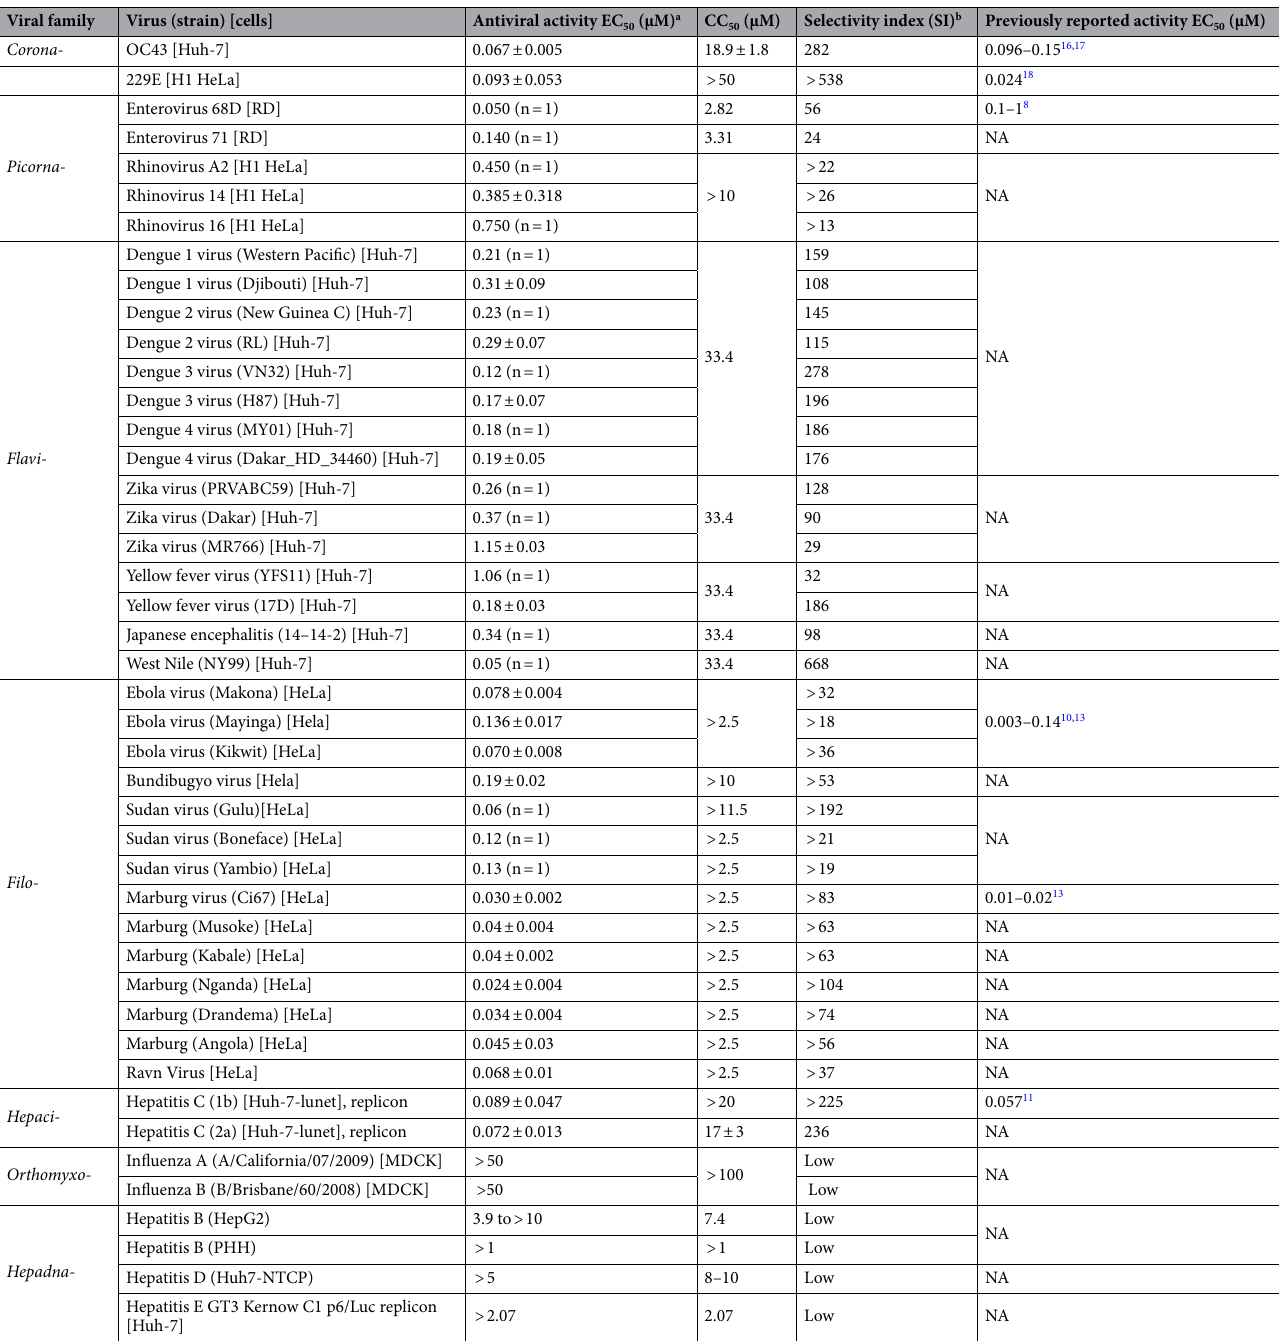
Table 1. Antiviral activity of RDV against a broad panel of infectious human viruses. NA data is not available. a Unless noted, EC 50 values are average ± standard deviation from at least 2–3 independent measurements. The studies marked n = 1 contain 2–4 technical replicates. For ease of comparison, literature values are listed when applicable. However, different cells and/or different assay protocols were used to generate the literature values. b Selectivity Index = CC 50 /EC 50 . When minimal RDV antiviral activity is observed for a particular virus, low SI is